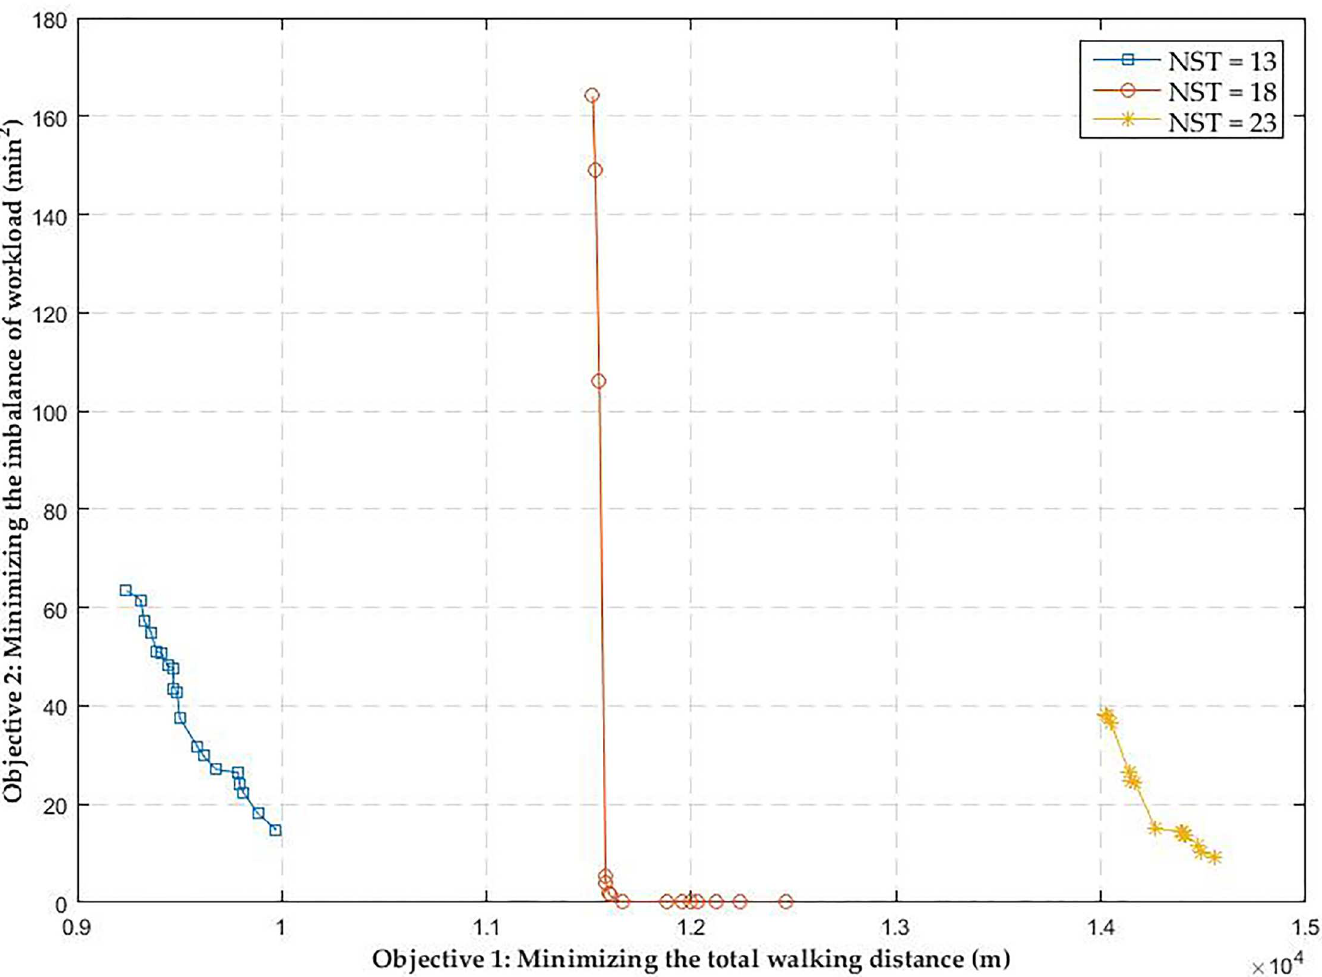
Fig 8. Sensitivity analysis on the number of shunting